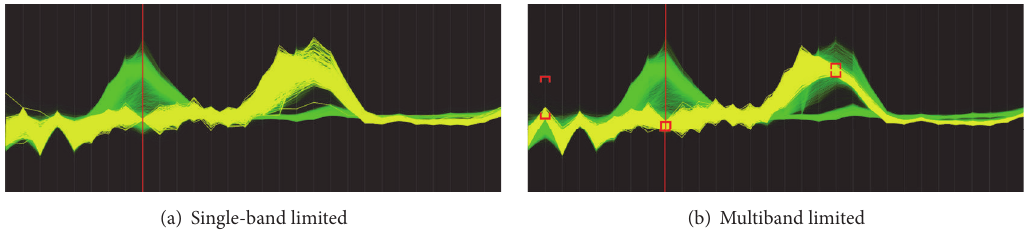
Figure 5: Highlighting modes used in the spectral gradient distribution view of a scene with two objects. In (a), one objects is highlighted. In (b), further discrimination is performed by adding intensity bounds in two further